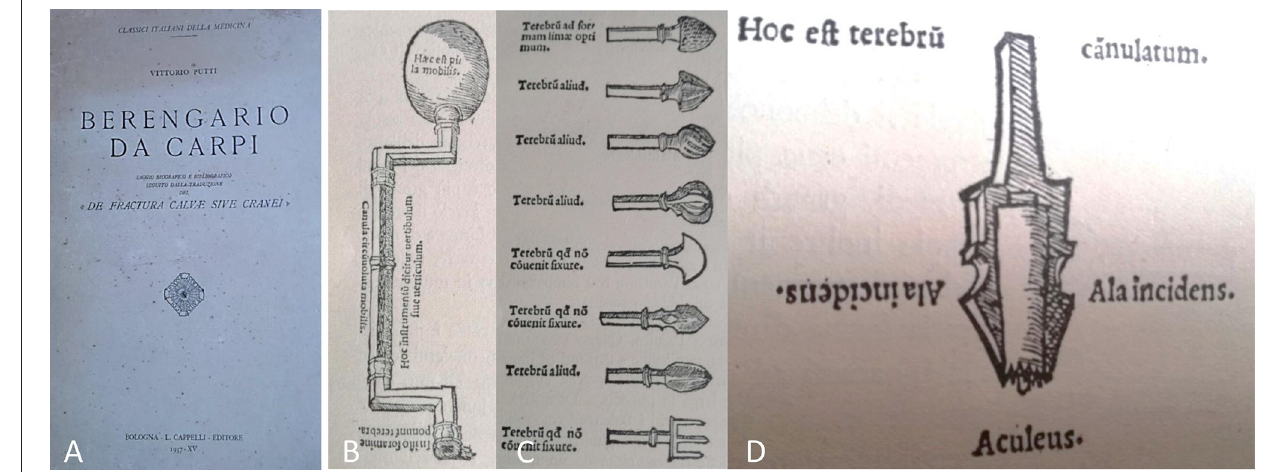
FIGURE 1 | (A) Frontispiece of De Fractura Calvae sive Cranei, original Italian translated copy (from Vittorio Putti, Berengario Da Carpi “De Fractura Calvae sive Cranei”, Bologna—L. Cappelli Editore, 1937, private collection. Figure is in public domain and no permission is required for reuse). (B–D) These pictures show some of the surgical instruments in use at that time to perform a